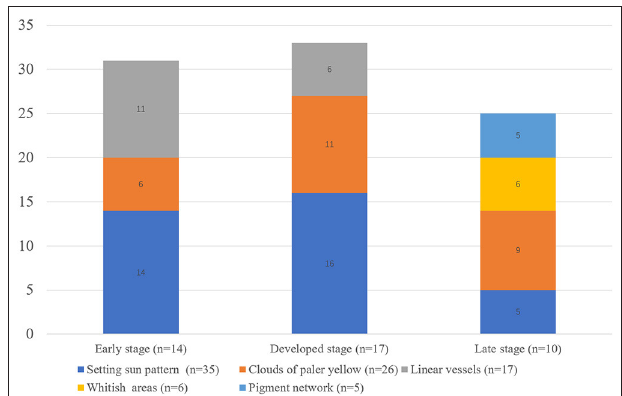
FIGURE 1 | Dermoscopic feature distribution in various histological stages.